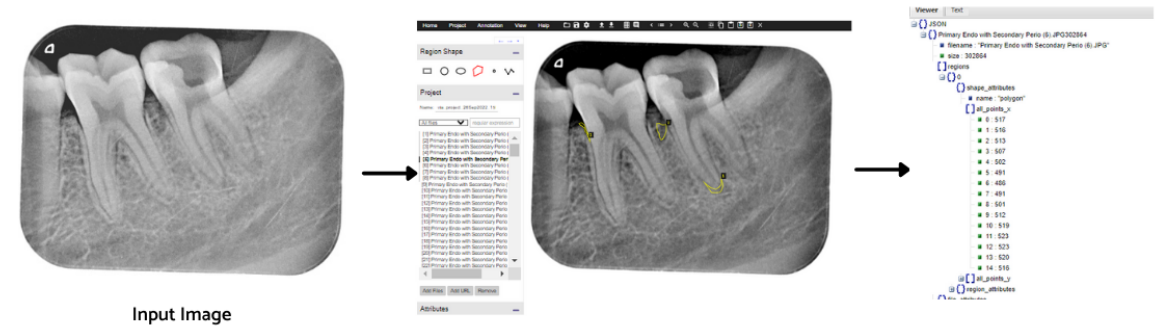
Figure 3. Image labeling process using the VIA